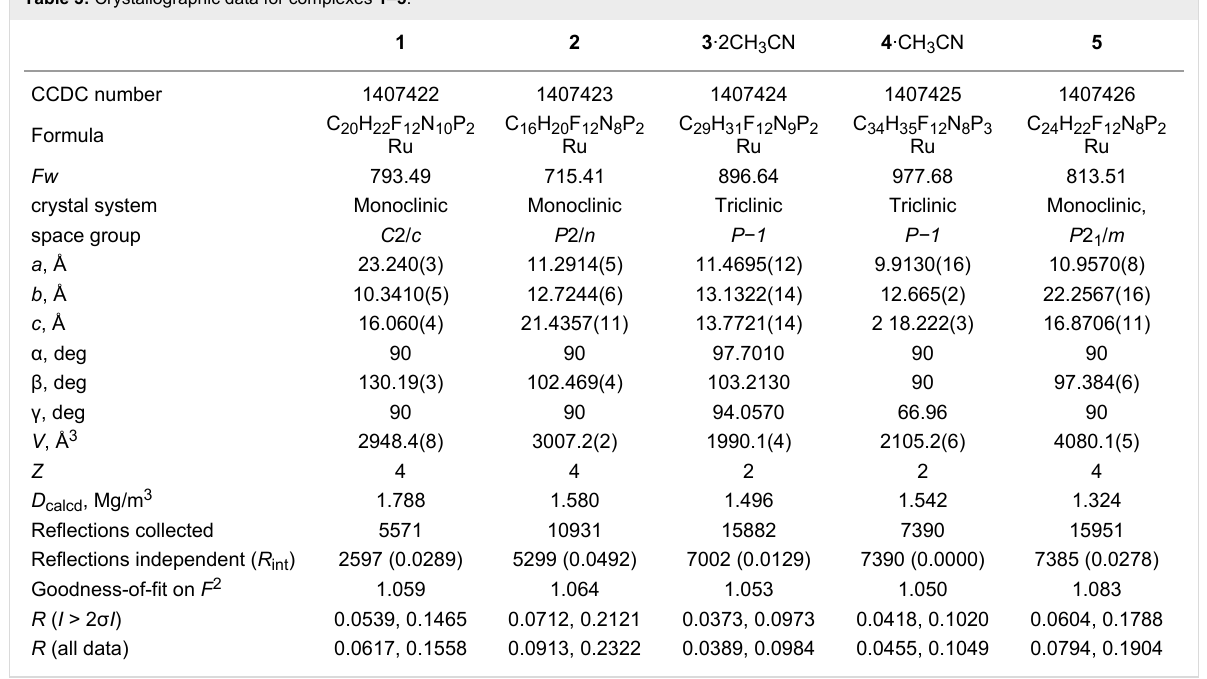
Table 3: Crystallographic data for complexes 1 – 5